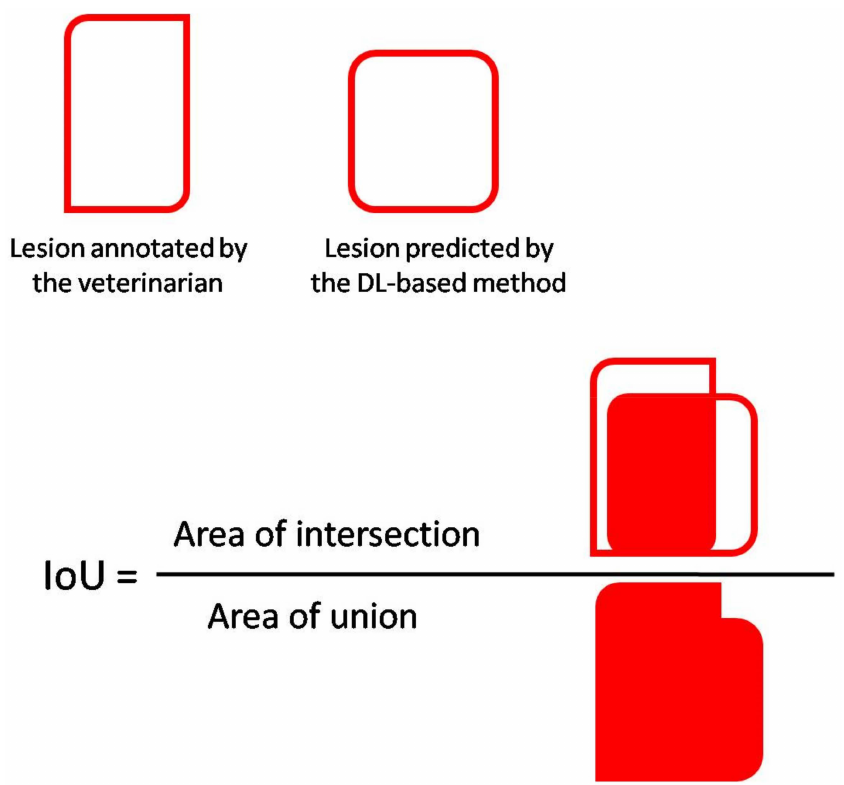
Figure 4. A graphical representation of the Intersection over Union (IoU). IoU can range between 0 and 1and it is recognized as a good metric for measuring overlap between two “masks”. The IoU value 1 is when the prediction is completely correct (i.e., when the prediction of the DLBM fully overlaps with the annotation of the veterinarian). Conversely, the lower the IoU is, the worse the prediction of the DLBM is (the IoU value is 0 when the two masks do not overlap at